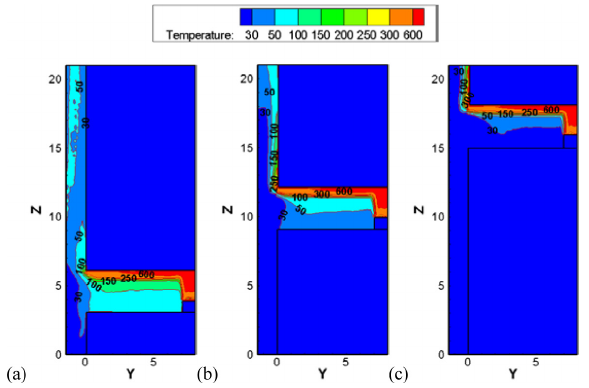
Fig. 7. Temperature distribution at the steady state with Q = 5MW when: (a) Fire on the 2 nd floor; (b) Fire on the 4 th floor; and (c) Fire on the 6 th floor